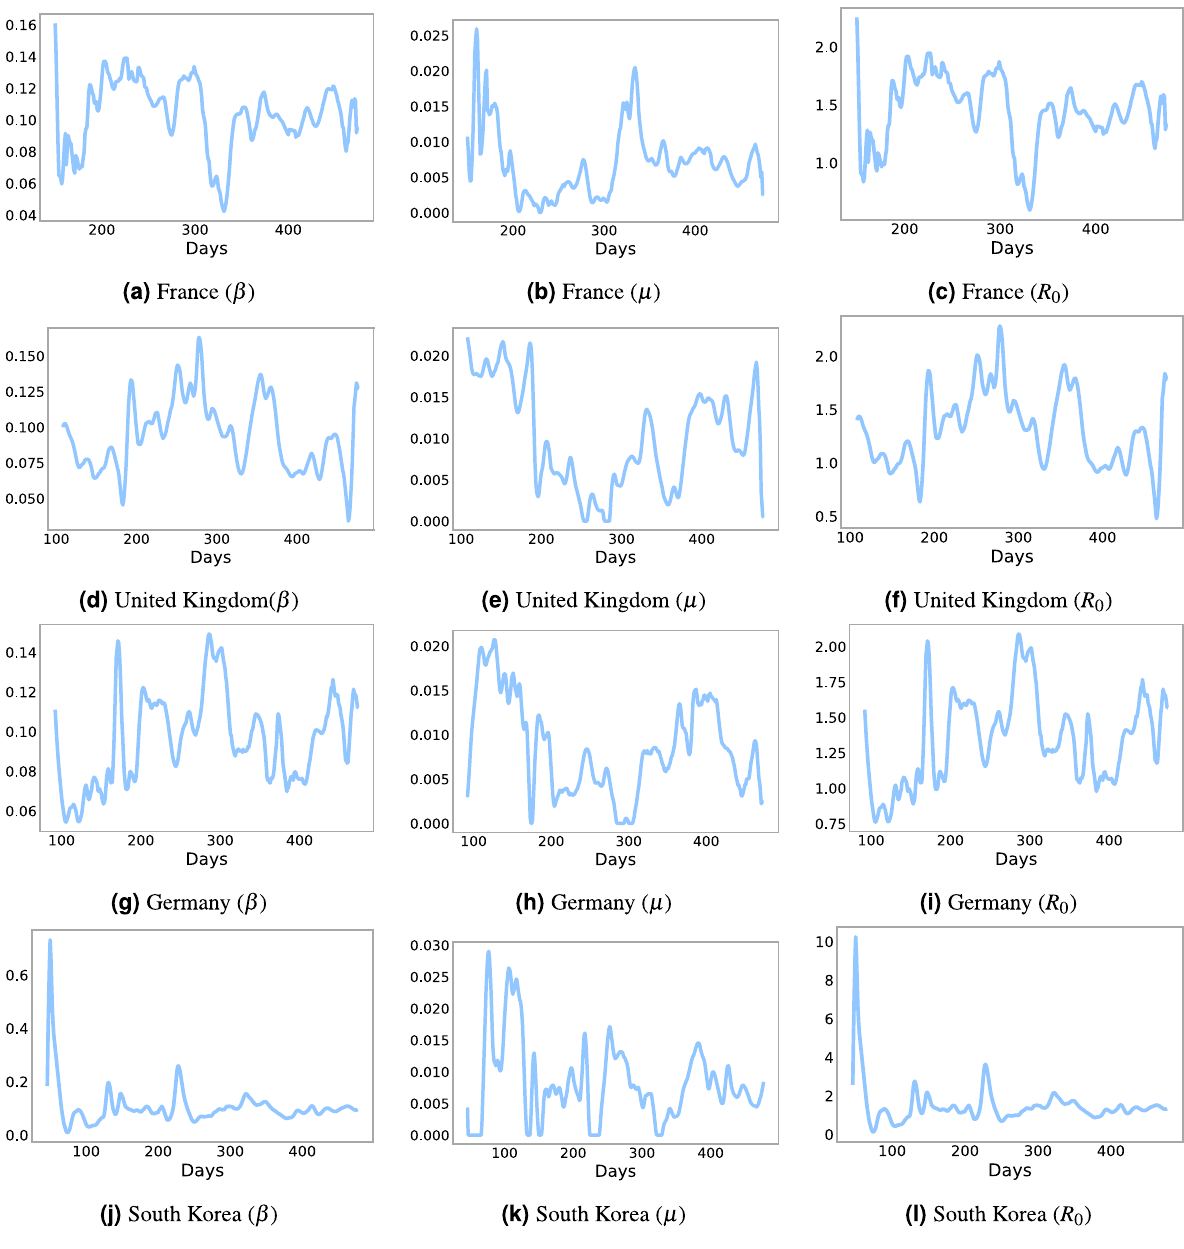
Figure 1. Predicted time varying parameters β (contact rate), µ (deceased rate), and R 0 reproduction number for each country derived from the Levenberg–Marquardt